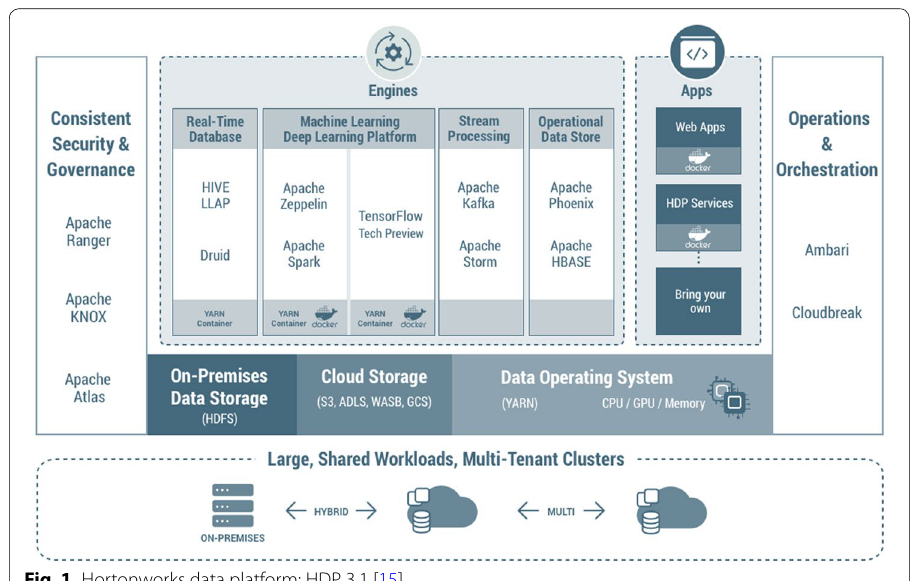
Fig. 1 Hortonworks data platform: HDP 3.1